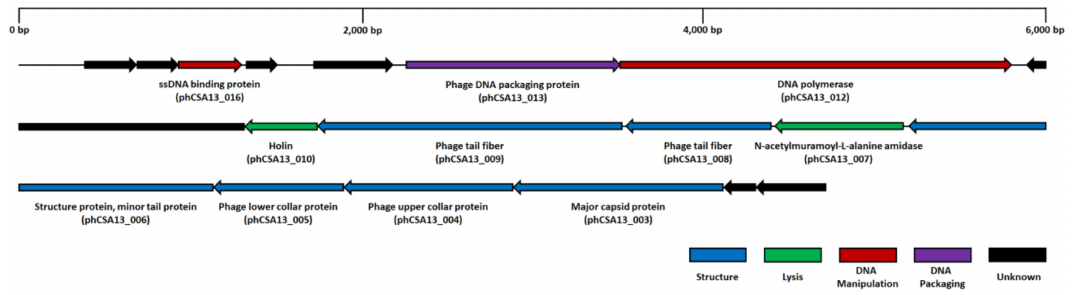
Figure 4. Genome map of phage CSA13. The arrangement of predicted ORFs on the CSA13 genome. Functional groups are categorized into